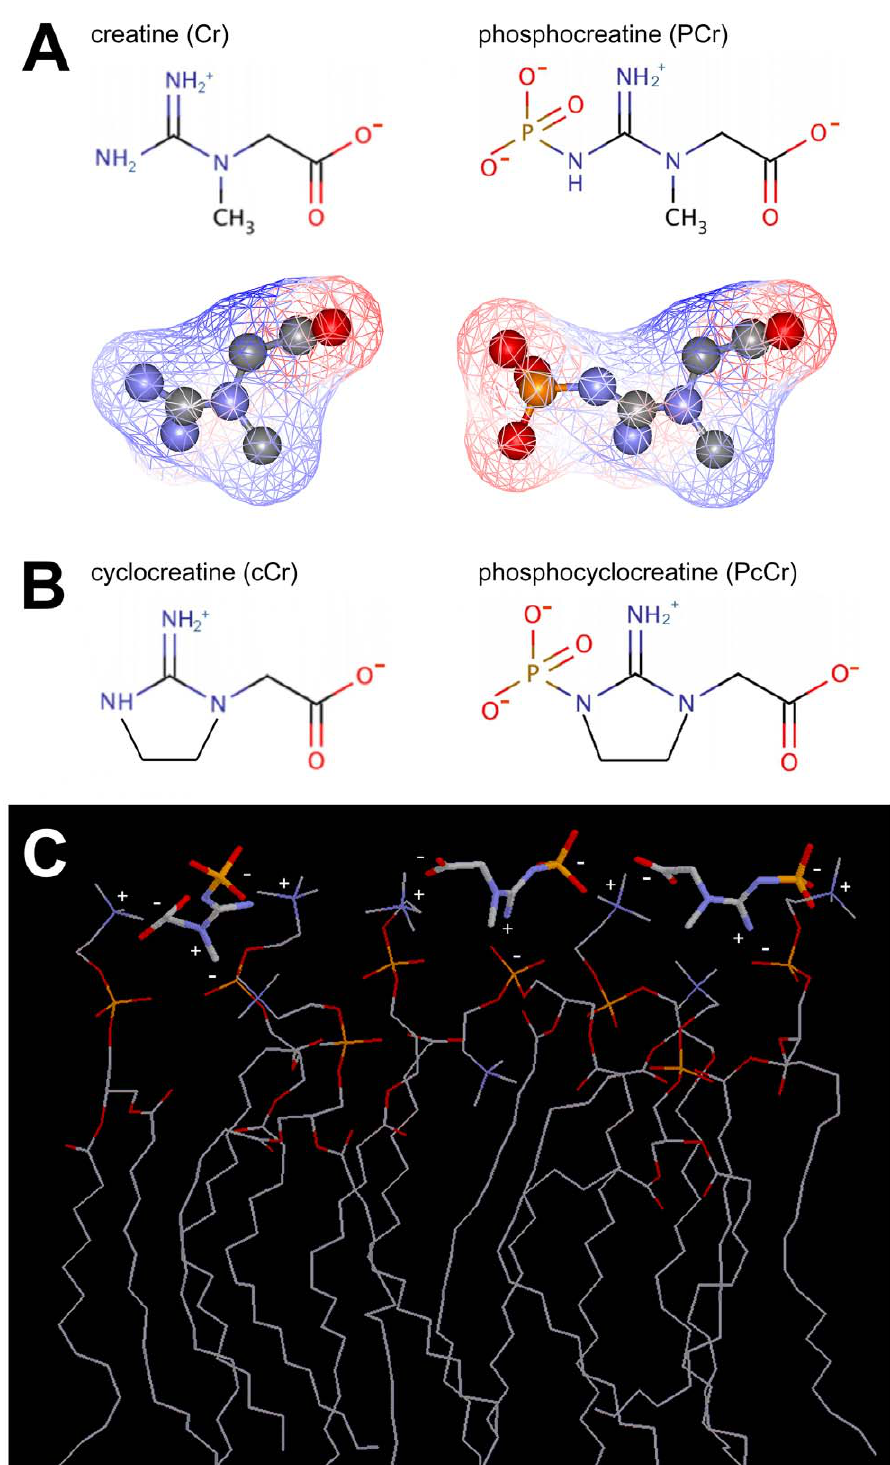
Figure 7. Structure and putative phospholipids interaction mechanism of phosphocreatine and its analogues. (A) Chemical structures of Cr, PCr (top) as well as the electrostatic potential (red, positive; blue, negative) at the solvent-accessible surface (mesh representation), superimposed on the ball-and-stick representations of Cr and PCr (bottom). (B) Chemical structures of the cyclic analogues cCr and PcCr. (C) Proposed interaction between PCr (bold line representation) and the zwitterionic headgroups of an array of eight dioleoyl phosphatidylcholine molecules (DOPC, thin line representation) with (partial) charges indicated. Structures prepared with WebLabViewer Pro v4.0 (for details see Materials and Methods).